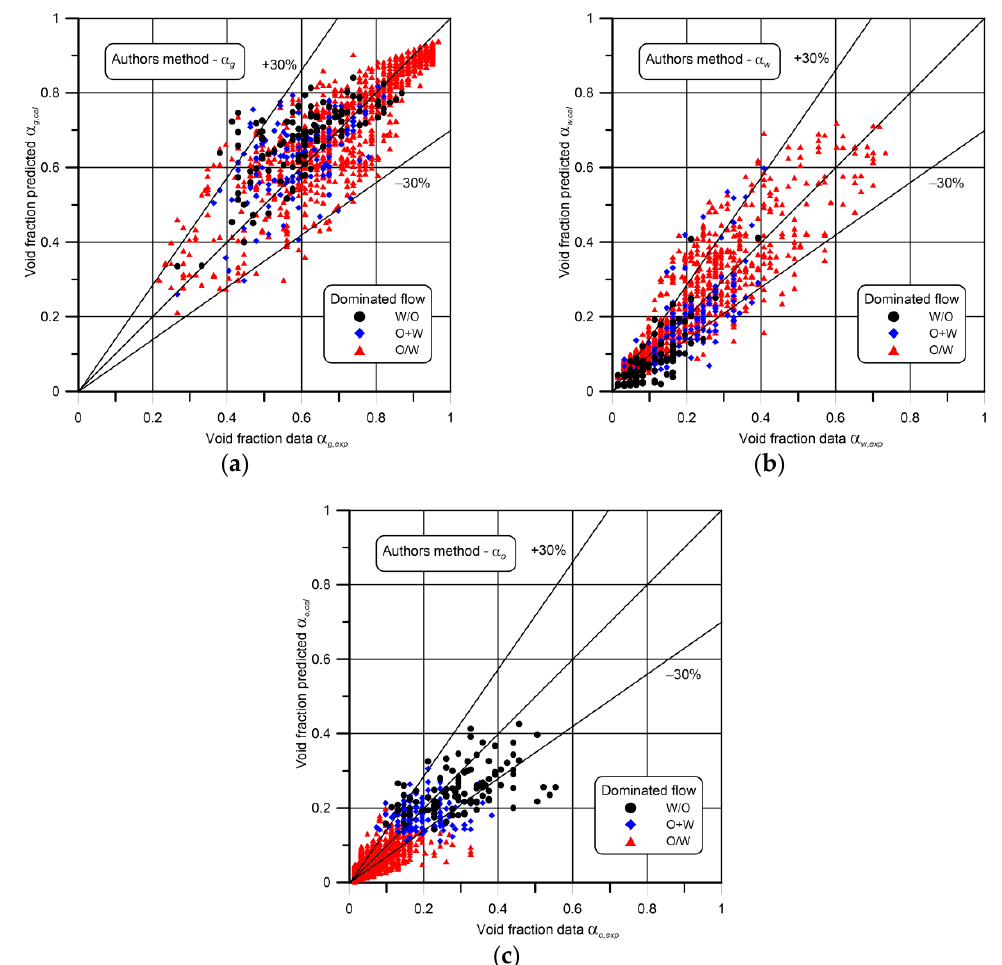
Figure 10. Comparison of measured and calculated values of void fraction for ( a ) gas α g , ( b ) water α w , and ( c ) oil α o , according to the proposed method.